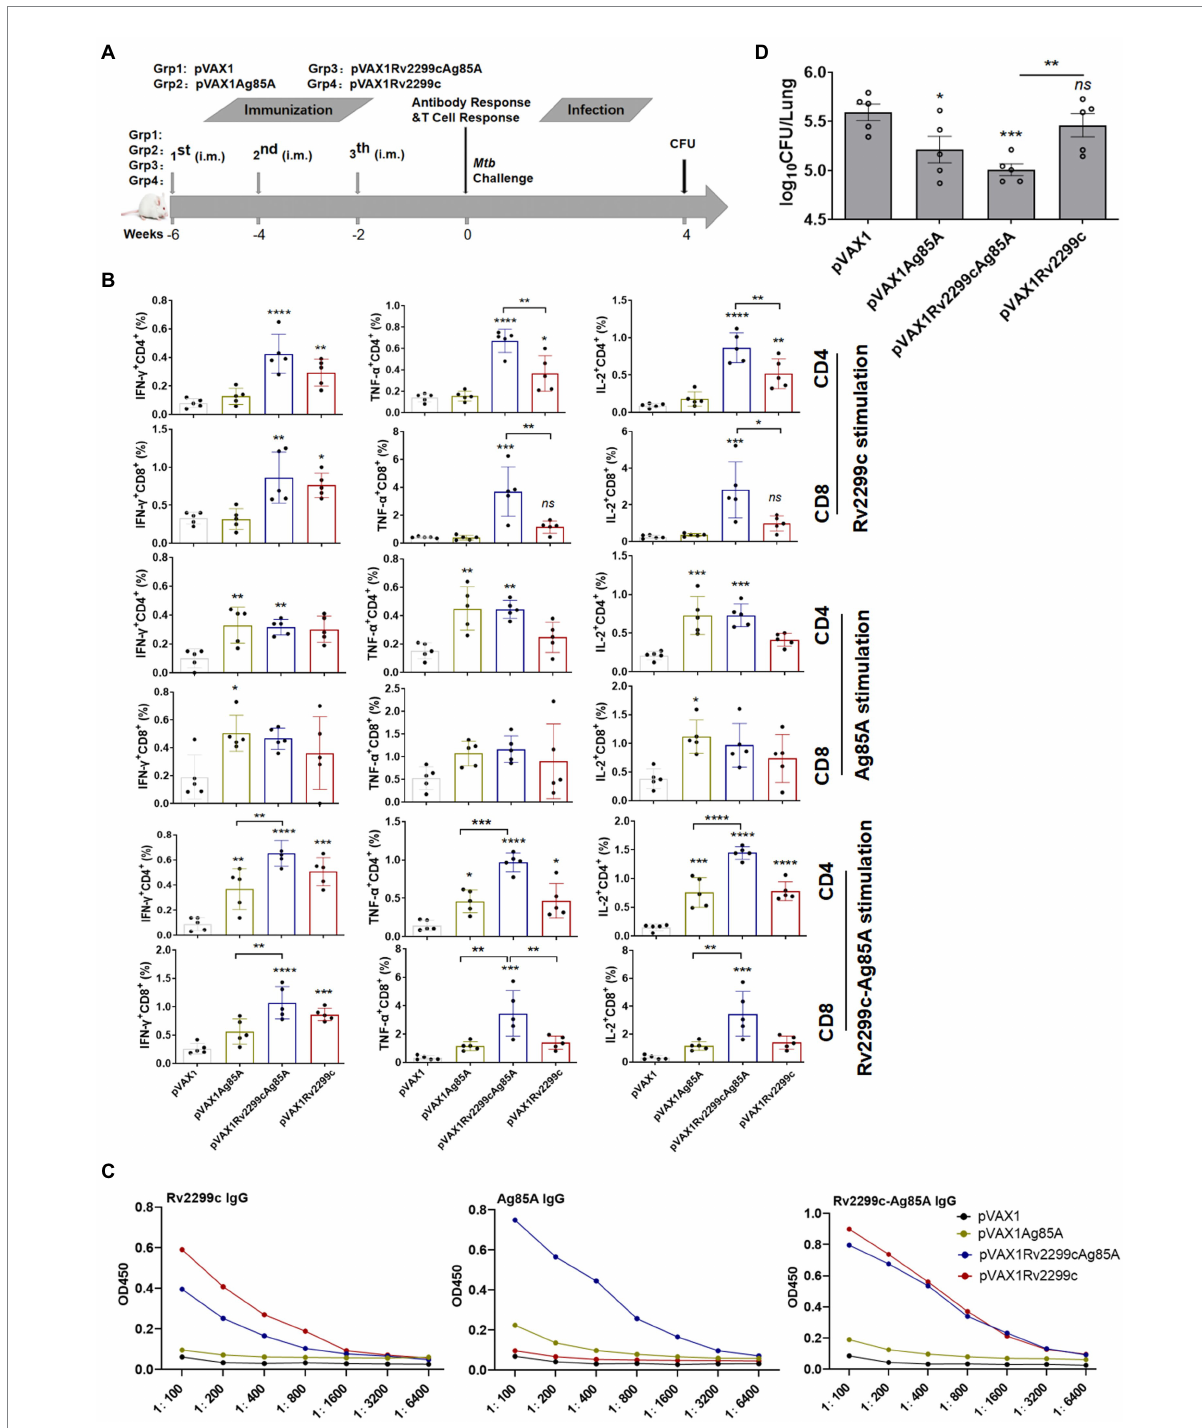
FIGURE 1 Preliminary demonstration that DNA vaccines expressing fusion antigens Rv2299c and Ag85A are moderately immunogenic and can afford protection. (A) Vaccination and infection schedule. Six weeks after the primary immunization, the mice were sacrificed, then splenocytes were collected and treated with Rv2299c (10 μ g/ml) or Ag85A (10 μ g/ml) at 37 ° C for 15 h in the presence of GolgiStop and intracellular cytokine staining was evaluated by flow cytometry. (B) The overall percentages of CD4 + or CD8 + T cells producing IFN- γ , TNF- α , or IL-2 after stimulation with Rv2299c or Ag85A or 2299c-Ag85A ( n = 3 mice, one-way ANOVA, mean ± SEM). (C) Specific IgG responses to antigen Rv2299c or Ag85A or Rv2299c-Ag85A in serum assayed six weeks after the primary immunization ( n = 3 mice). (D) Pulmonary bacterial burden, Log 10 CFU, at four weeks after Mtb H37Rv challenge. ( n = 5 mice, two tailed P and unpaired t test).Data are representative of two independent experiments with at least three mice per group.* p < 0.05, ** p < 0.01,*** p < 0.001, **** p < 0.0001: a significant difference of treatment groups from the appropriate controls (pVAX1 group). ns , no significant